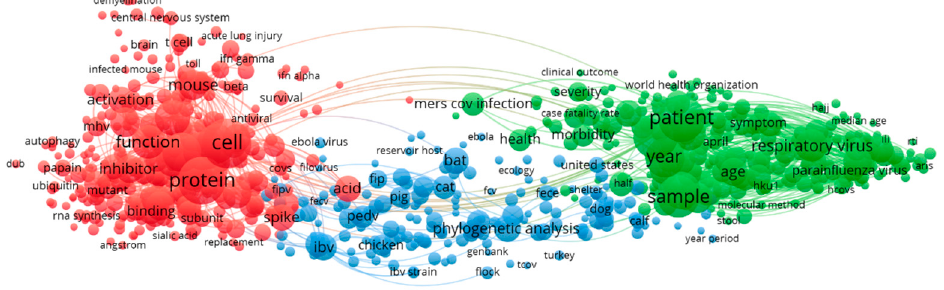
Figure 8. 2012 – 2015 term co-occurrence map. Figure 8. 2012–2015 term co-occurrence map.